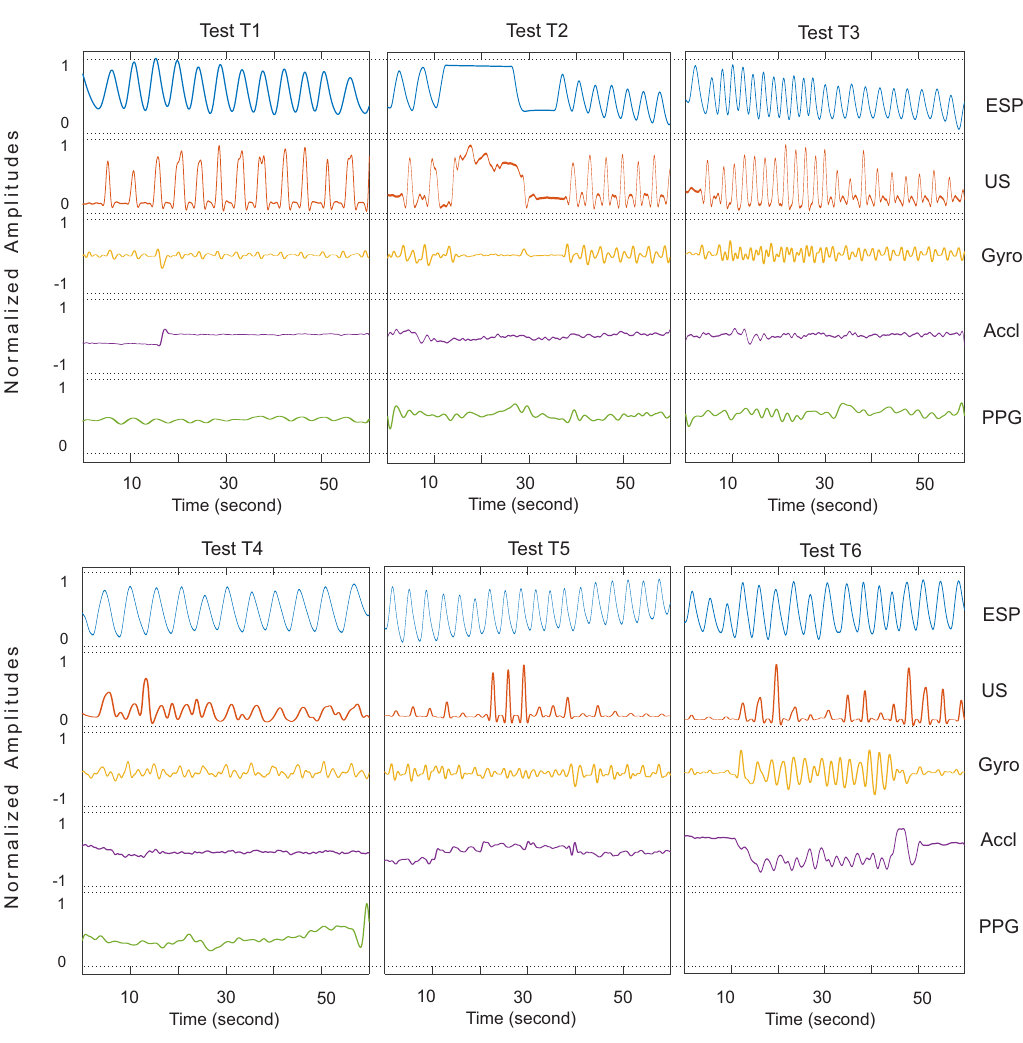
Figure A2. Respiratory waveforms of Subject